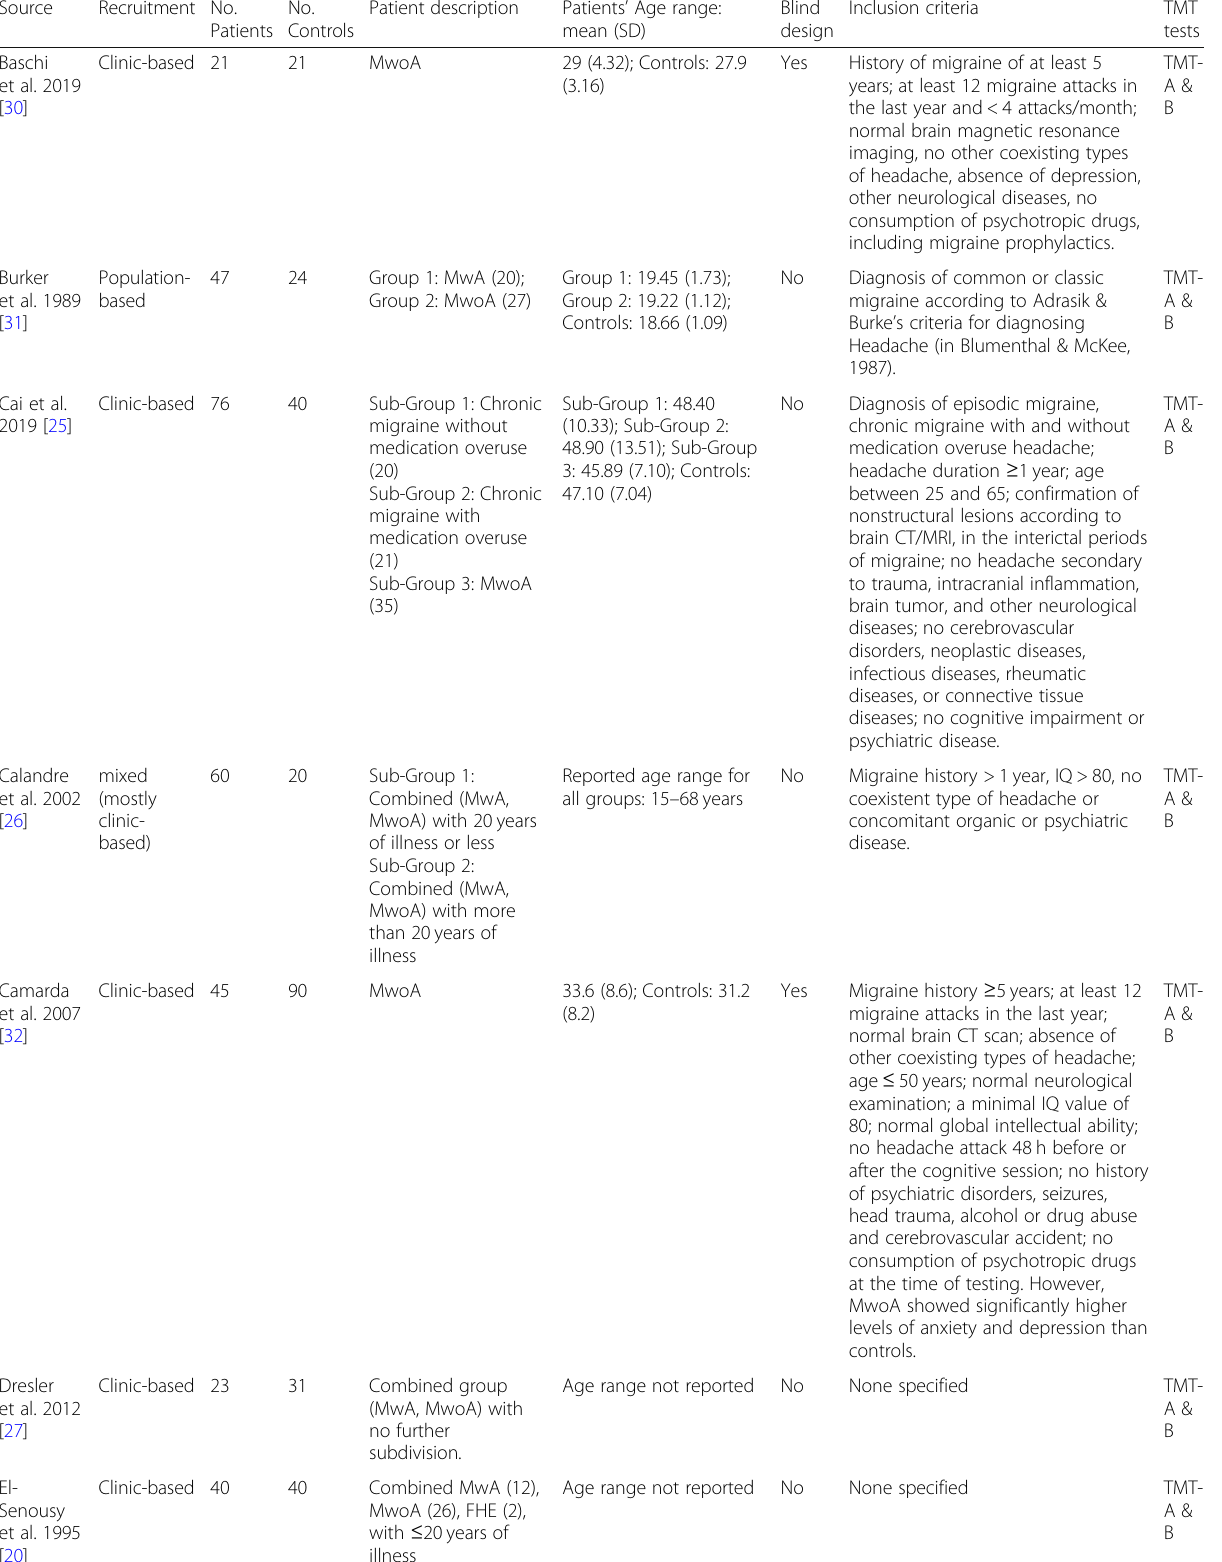
Table 1 Summary of included studies assessing performance of patients with migraine on Trail Making Test (TMT)